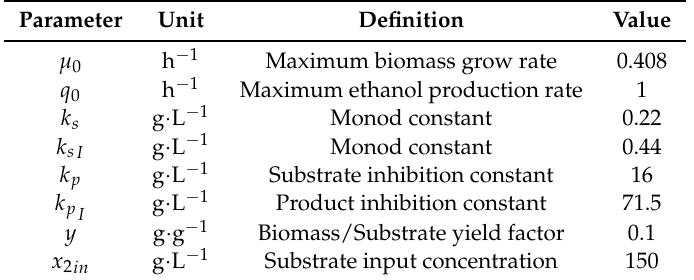
Table 1. Parameters of the aforementioned model for fed-batch ethanol production